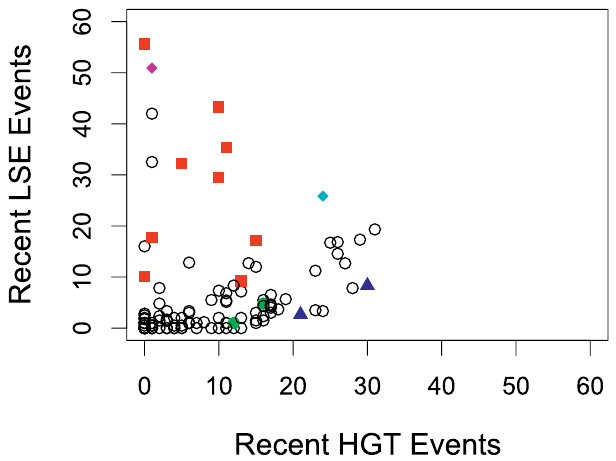
Figure 4. LSE Events versus HGT Events The number of LSE and HGT events for each genome are shown. Colored symbols correspond to the genomes identified in Figure 1. Note the position of the red squares well above the x -axis.